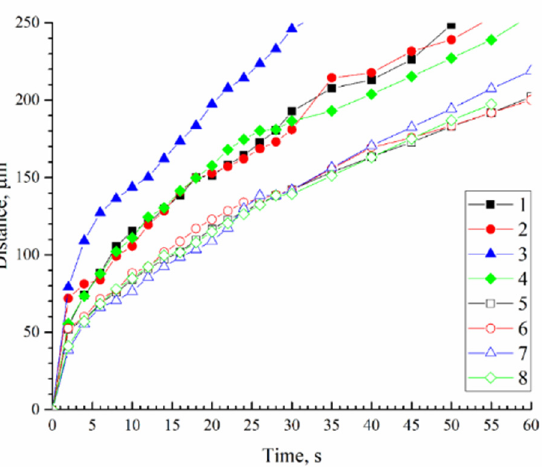
Figure 10. The distance by structure formation boundary from the surface with time for different casting solution compositions: 1—15 wt.% PAN with DMSO; 2—15 wt.% PAN with DMSO/Acetone ratio 90/10; 3—15 wt.% PAN with DMSO/Acetone ratio 50/50; 4—20 wt.% PAN with DMSO; 5—15 wt.% PAN with NMP; 6—15 wt.% PAN with NMP/Acetone ratio 90/10; 7—15 wt.% PAN with NMP/Acetone ratio 70/30; 8—20% PAN with NMP.